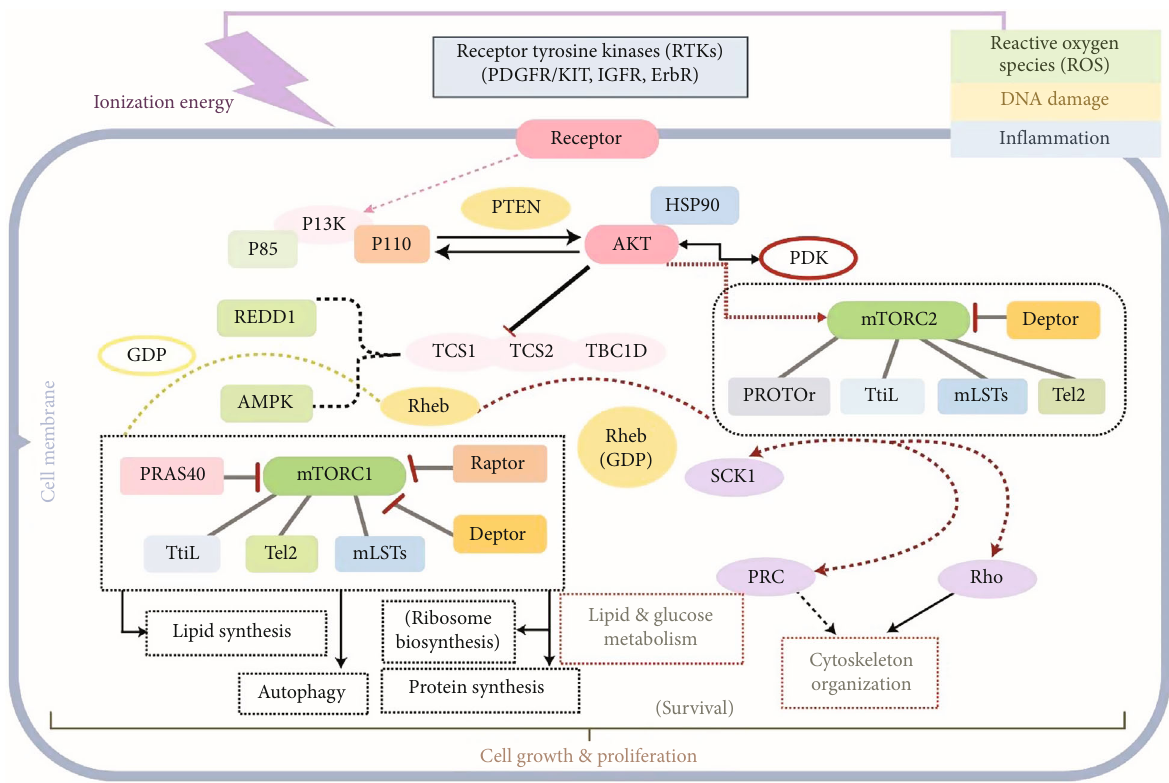
Figure 2: PI3K/AKT/mTOR pathway. Receptor tyrosine kinase activates the mTOR pathway. Hyperactivation of mTOR1 occurs due to TSC1/2 mutations. Downstream signaling pathway results in lipid and protein synthesis, ribosome biosynthesize, and autophagy. Similarly, mTOR2 downstream signals to lipid and glucose metabolism and cytoskeleton organization which accelerated cell division, proliferation, and irregular gene expression that exemplify TSC; RTKs: receptor tyrosine kinase; PDGFR: plate-let-derived growth factor receptor; KIT: protooncogene receptor; IGFR: insulin-like growth factor receptor; mTOR: mammalian target of rapamycin; PI3K: phosphatidylinositol 3-kinase; PTEN: phosphatase and tensin homologue deleted on chromosome 10; RHEB: Ras homologue a small GTP-binding protein enriched in the brain; TSC: tuberous